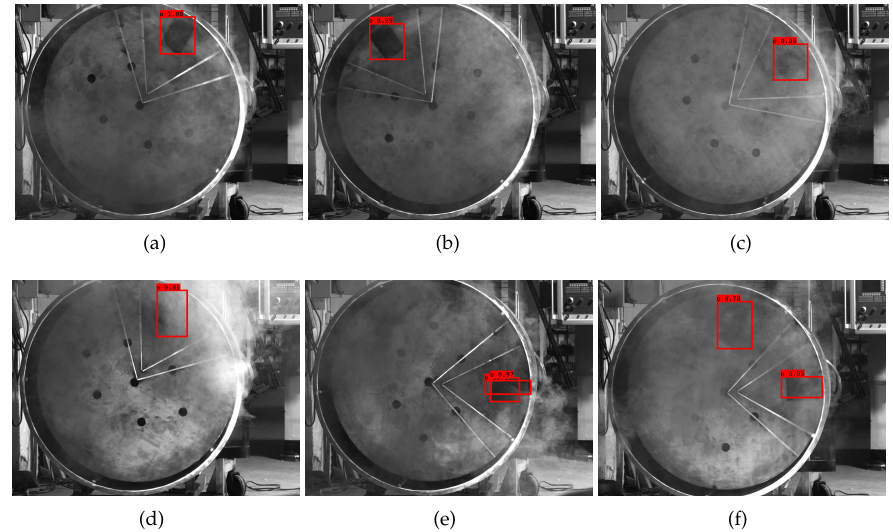
Figure 16. Detection results of YOLO-MobileNet model: ( a–c ) good detection results, ( d–f ) parameter coordinate system.